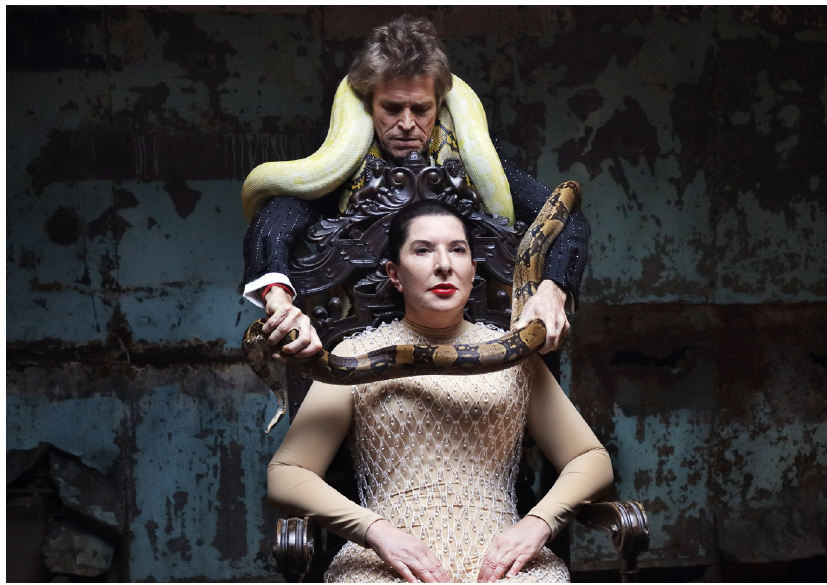
Fig. 1 Marina Abramovi ć , 7 Deaths of Maria Callas , 2019. Photo credit: Marco Anelli, courtesy of the Marina Abramovi ć